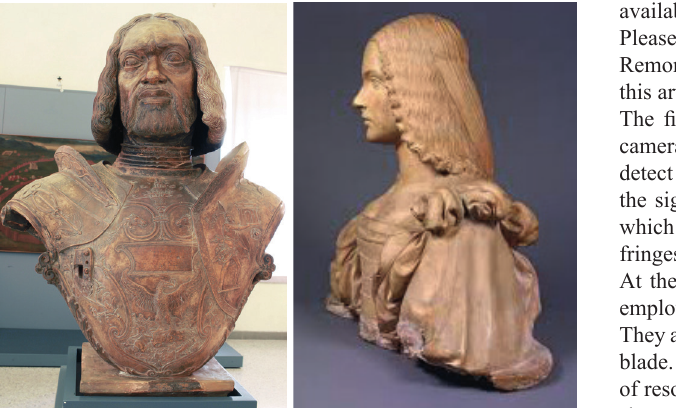
Figure 1: on the left, the bust of Francesco II Gonzaga in the museum of Mantova, on the right the bust of Isabella d’Este of the Kimbell Art Museum in Texas (USA). Both sculptures are the work of Gian Cristoforo